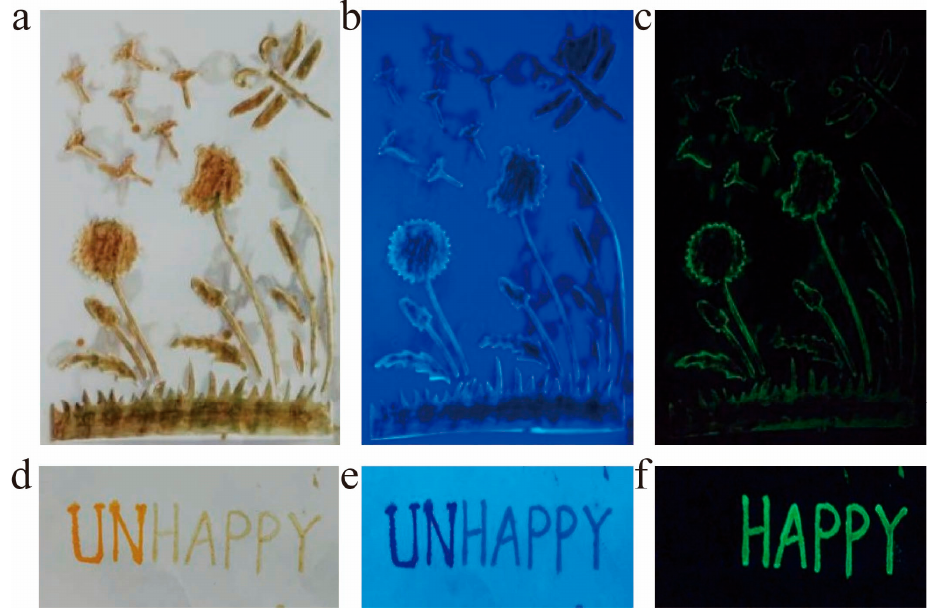
Figure 5. Photographs of pa tt erns and words drawn on A 4 paper with a long afterglow material solution. Pa tt erns under daylight ( a ) with text ( d ), pa tt erns under UV light ( b ) with text ( e ), and pa tt erns under darkness ( c ) with text ( f ).